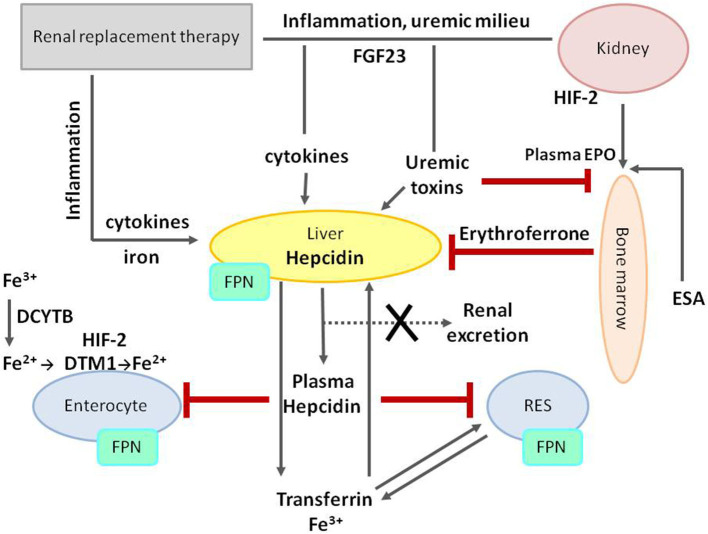
Iron metabolism dysregulation in chronic kidney disease. The central role in iron metabolism regulation plays an increased level of hepcidin, decreasing FPN on cell membranes and thus diminishing duodenal iron absorption and acquirement from stores in RES. Hepcidin expression and production are stimulated by iron treatment, inflammation, uremic milieu, and fibroblast growth factor 23 (FGF23), and, at the same time, its removal is impaired due to decreased glomerular filtration rate (GFR). Both erythropoietin and erythroferrone play suppressive effect on hepcidin production. FPN, ferroportin; RES, reticuloendothelial system; HIF-2, hypoxia-inducible factor 2; DCYTB, duodenal cytochrome B reductase; DTM1, divalent metal transporter 1; FGF23, fibroblast growth factor 23; EPO, erythropoietin; ESA, erythropoiesis-stimulating agent.